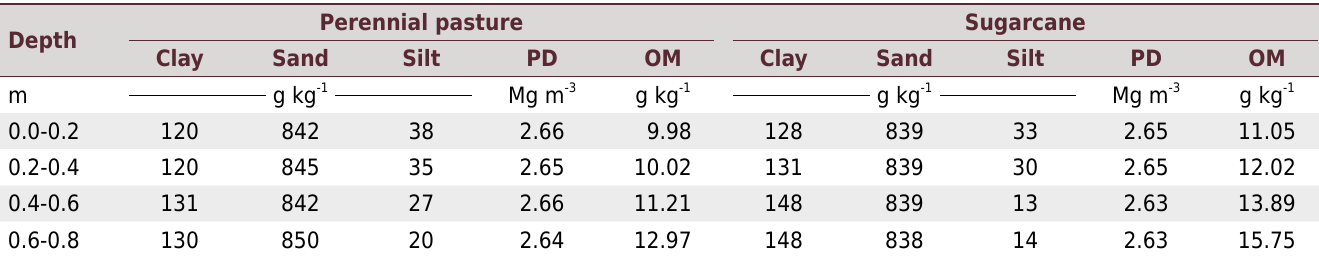
Table 1. Particle size analysis, particle density (PD), and organic matter (OM) in four layers of an Oxisol under two systems of soil use Perennial pasture Sugarcane Depth